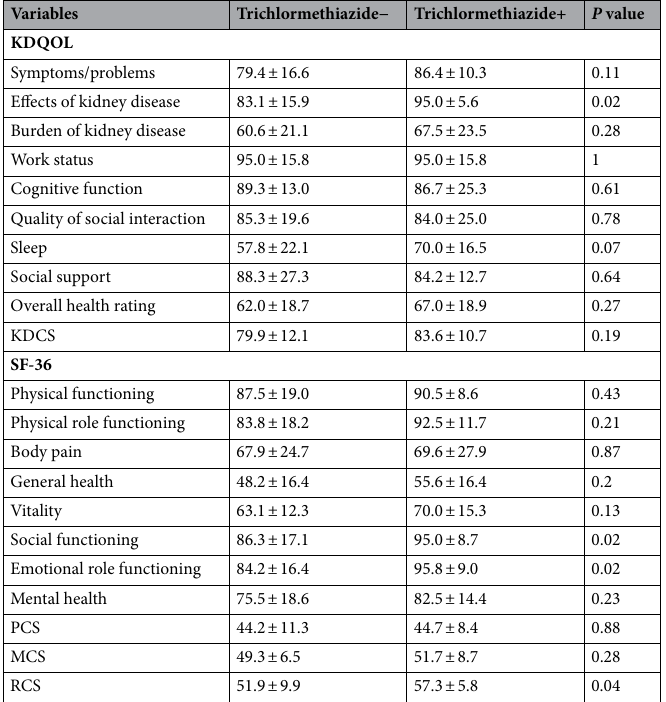
Table 3. Effect of trichlormethiazide on health-related quality of life. KDQOL Kidney Disease Quality of Life, KDCS kidney disease component summary, SF-36 Medical Outcomes Study 36-Item Short